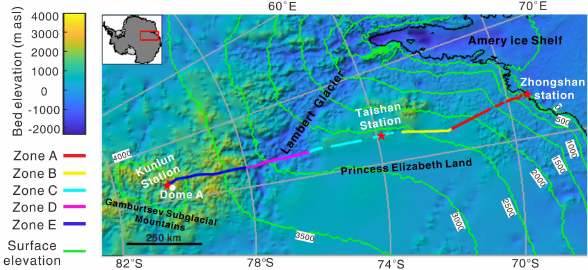
Figure 1. Map of the transect from Zhongshan to Dome A, East Antarctica. All of the bed elevation (the background image), surface elevation (the green line) and grounding line (the black line) are from Bedmap2 (Fretwell, et al.,2013). The red stars represent the location of Zhongshan station, Taishan station and Kunlun station, respectively. The white point marks the location of Dome A.